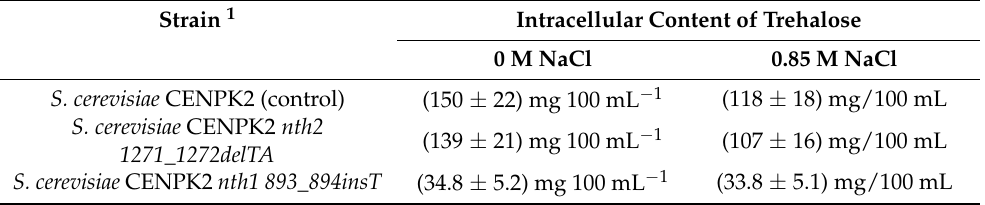
Table 2. Intracellular trehalose content of yeast cells under non-stress and stress conditions. Strain